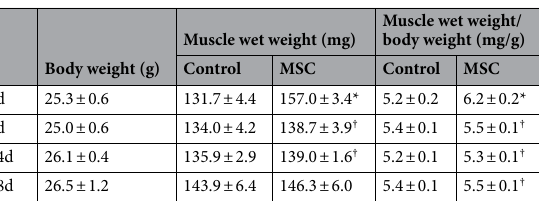
Table 2. Body and muscle weight. *P < 0.05 vs Control and † P < 0.05 vs ipsilateral muscle at 2 days post-